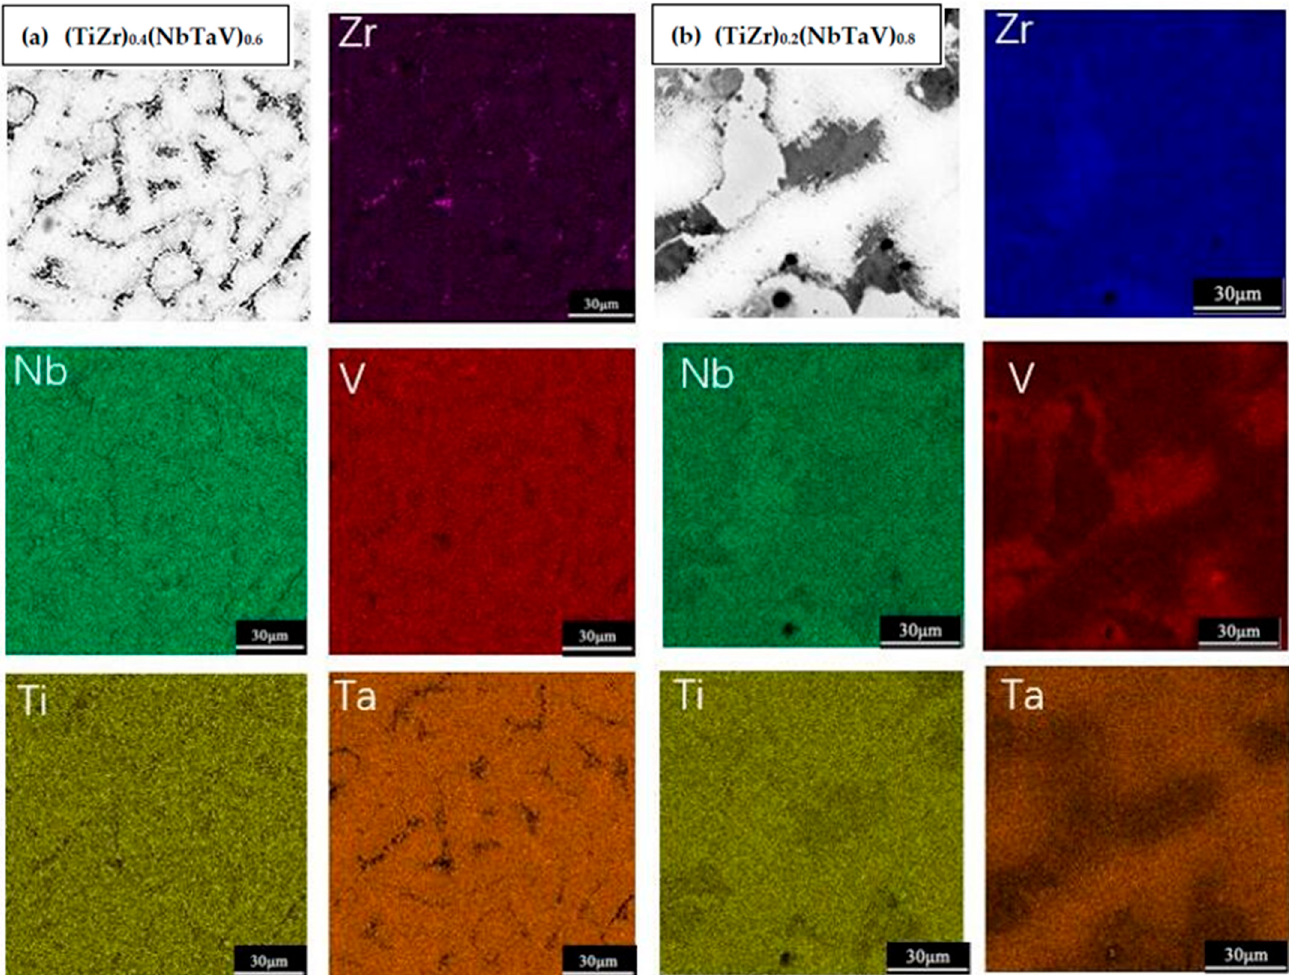
Figure 3. SEM and EDS mapping of Zr, Nb, Ti, V, and Ta in as-cast HEAs: ( a ) (TiZr) 0.4 (NbTaV) 0.6 and ( b ) (TiZr) 0.8 (NbTaV) 0.2 . ( b ) (TiZr) 0.8 (NbTaV) 0.2